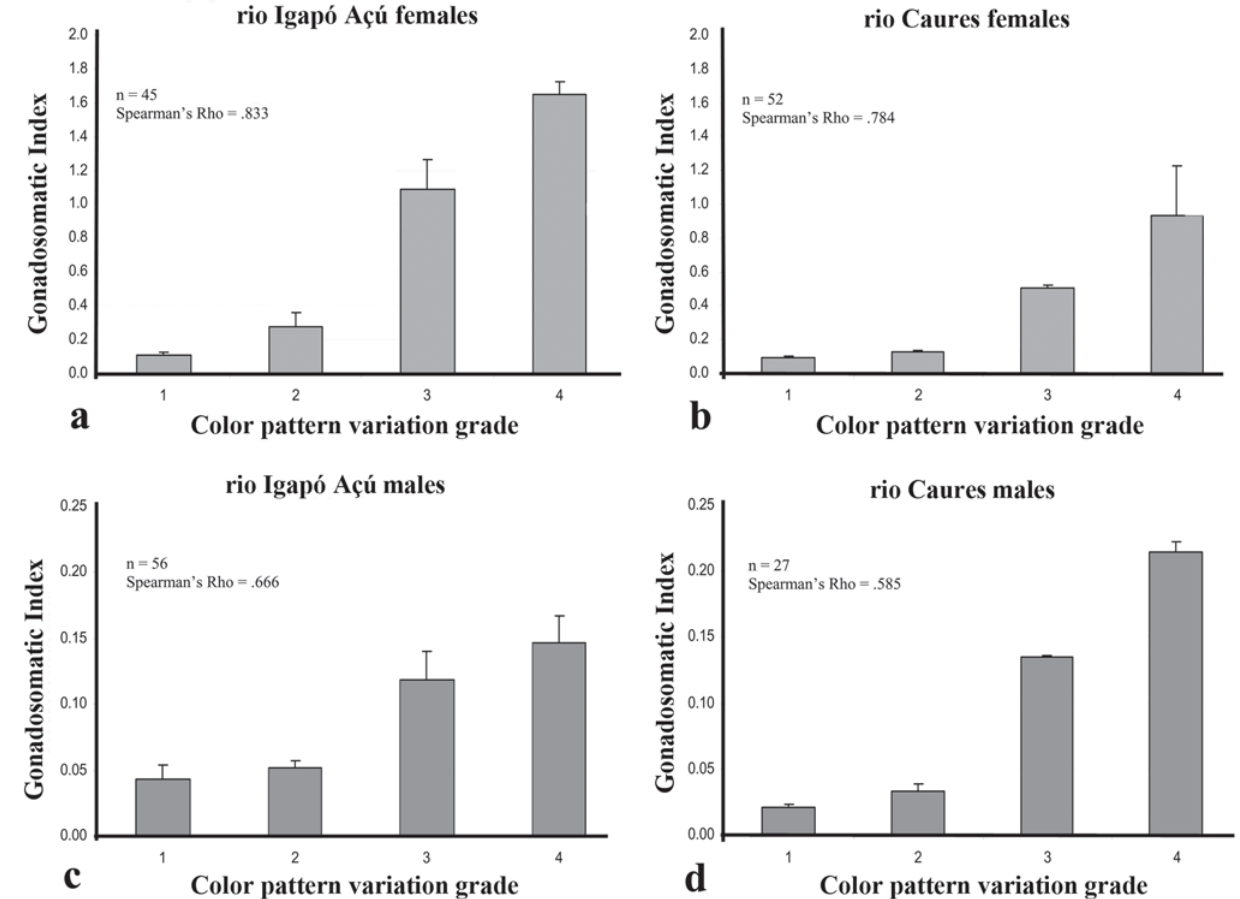
Fig. 5. Mean Gonadosomatic Index for C. temensis variants grouped by CPV grade. a ) Females from the Igapó Açú (Region 1). b ) Females from the rio Caures (Region 2). c ) Males from the Igapó Açú region. d ) Males from the rio Caures. A significant correlation between GSI and CPV Grade was found for males and females in both collecting regions, p < .01 for a, b, d, and